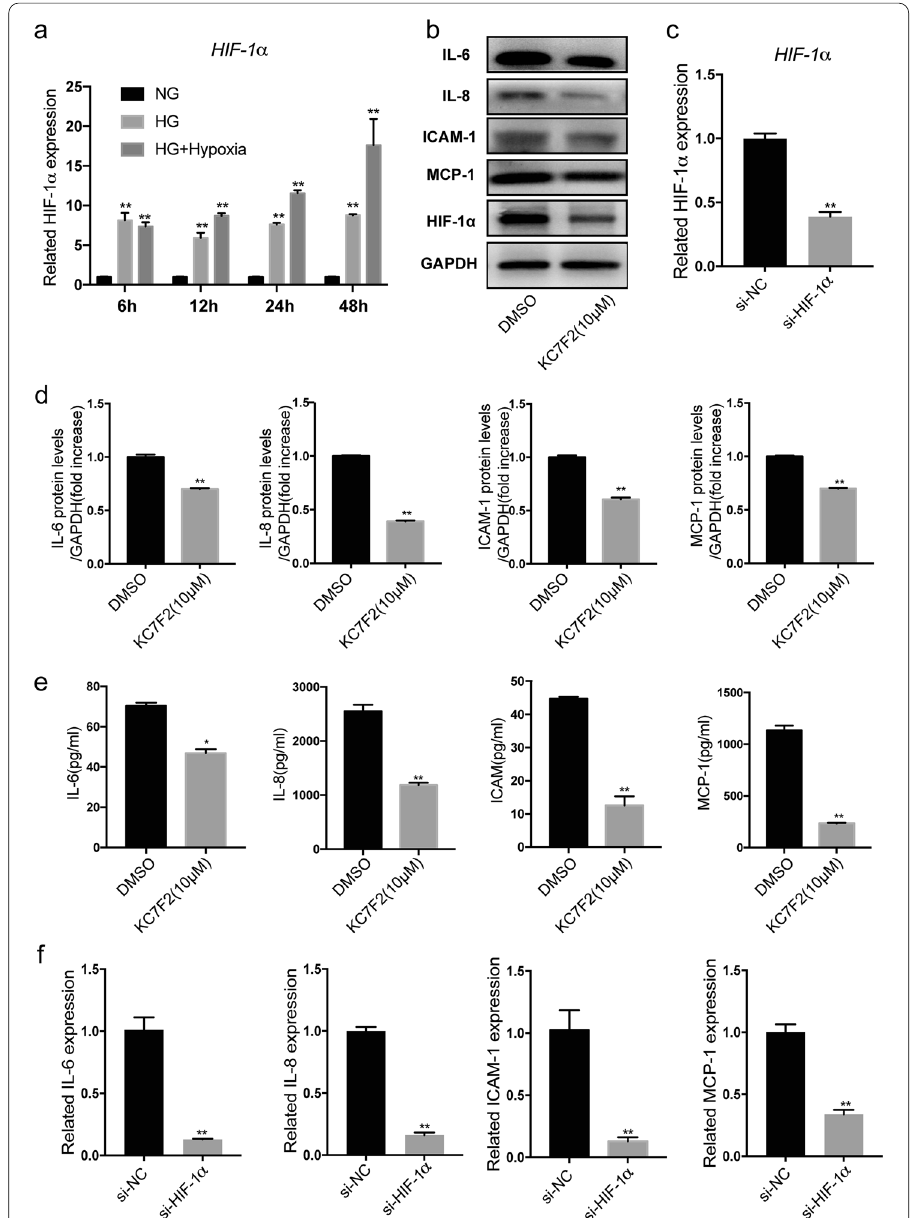
Fig. 3 Effects of inhibition of HIF-1α on expression of inflammation after hyperglycemic and hypoxia. a Cells were treated with glucose (25 mM) or with combined exposure to high glucose and hypoxia for 6, 12, 24, and 48 h. Exposure to glucose alone or combined stimulation with hypoxia significantly increased gene expression of HIF-1α. b Cells were treated with KC7F2 (10 µM) or si-HIF-1α for 48 h following combined stimulation, and IL-6, IL-8, ICAM-1, MCP-1, and c HIF-1α levels were analyzed. The relative density of IL-6, IL-8, ICAM-1, and MCP-1 ( d ) was normalized according to GAPDH expression. Importantly, the downregulation of HIF-1α decreased the secretion of IL-6, IL-8, ICAM-1 and MCP-1 based on ELISA and qRT-PCR assays ( e – f ). n 3; * p < 0.05 and ** p < 0.01 vs. DMSO. DMSO-treated cells, DMSO; HIF-1α inhibitors KC7F2 (10 µM)-treated = cells, KC7F2 (10 µM); si-HIF-1α, small interfering RNA HIF-1α; HG, high glucose; HG stimulus with high glucose and hypoxia; NG,